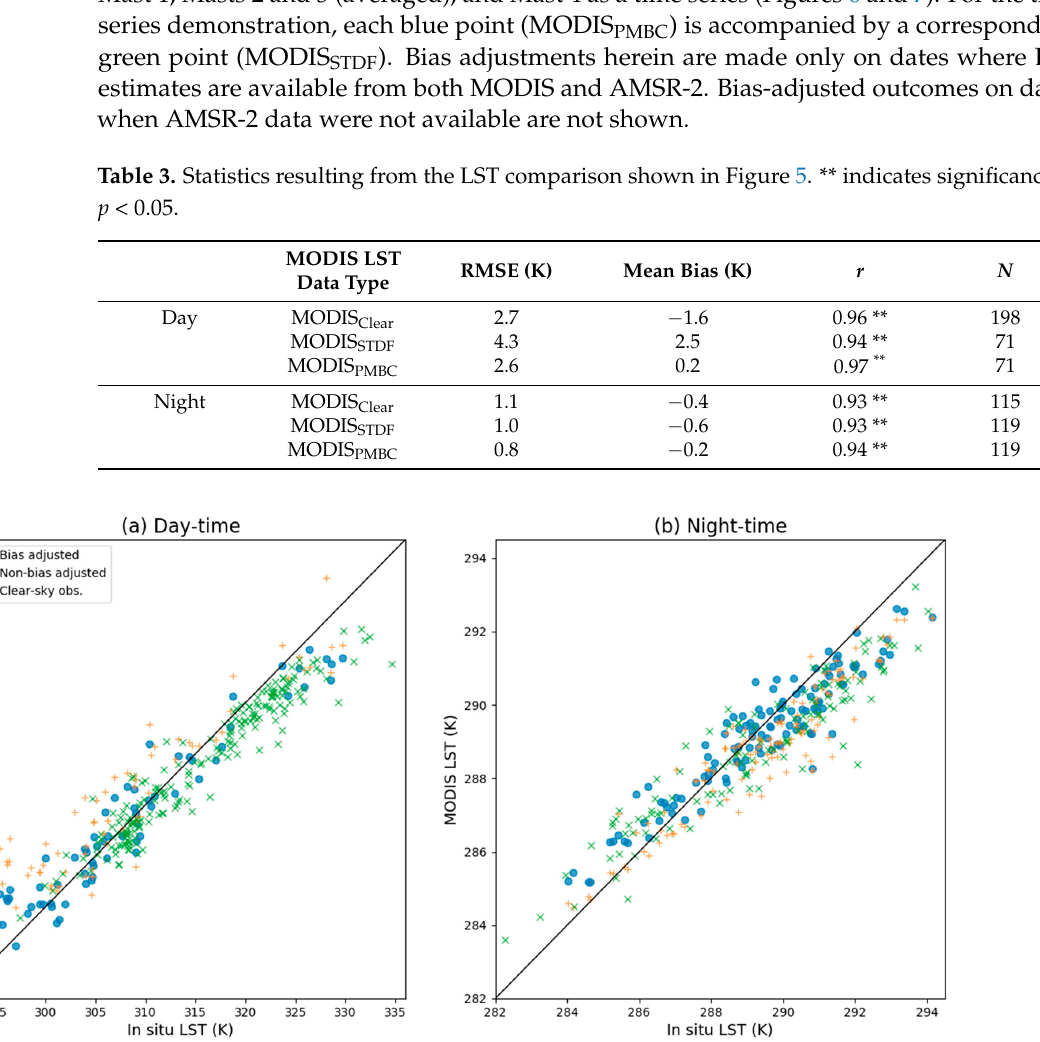
Figure 5. Comparison of MODIS Clear (green ‘x’), MODIS STDF (orange plus sign) and MODIS PMBC (blue dot) data to corresponding in situ LSTs recorded using the mast-mounted IR radiometers of the ILRI Kapiti Research Station detailed in Figure 1. Day-time data are collected around 1:30 p.m. local solar time, whereas night-time data are around 1:30 a.m. The 1:1 line is also shown, and comparison statistics are presented in Table 3. The clearest benefit of the bias-adjusted gap filling is seen in the coolest temperatures of the day-time record.